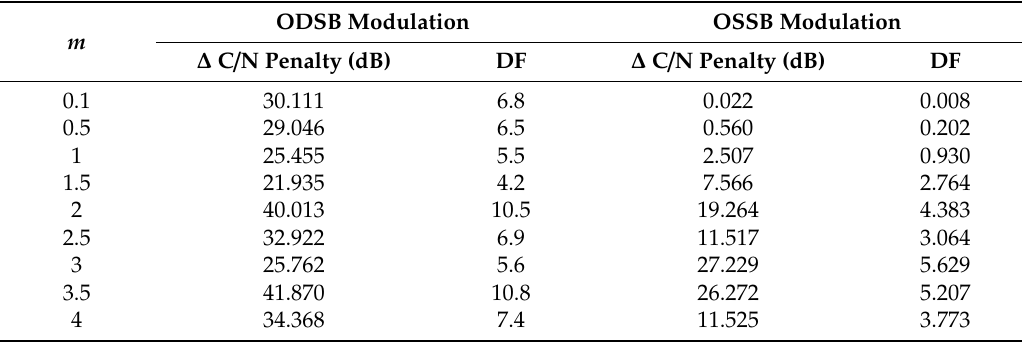
Table 3. Irregular θ scheme based on LD power distribution and variation in DD-MZM bias point.